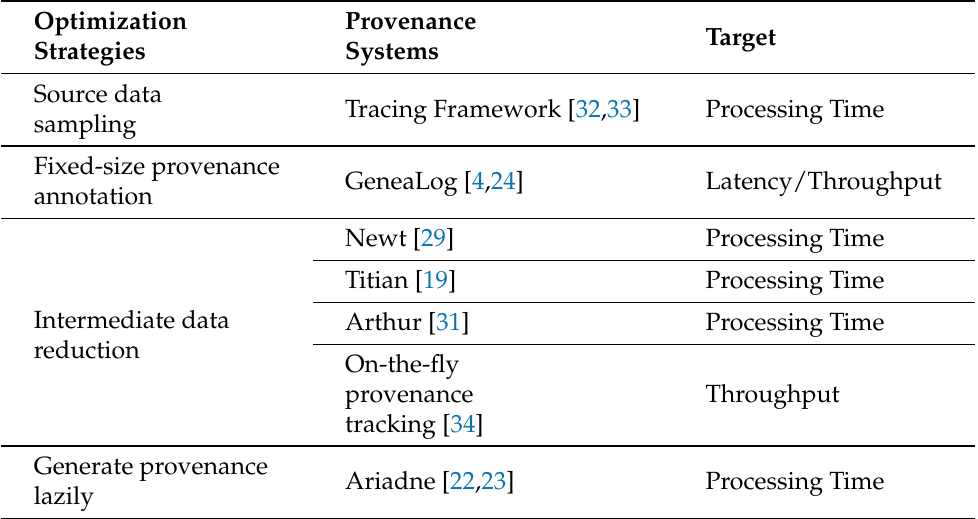
Table 6. Optimization solutions to reduce runtime overhead for big data